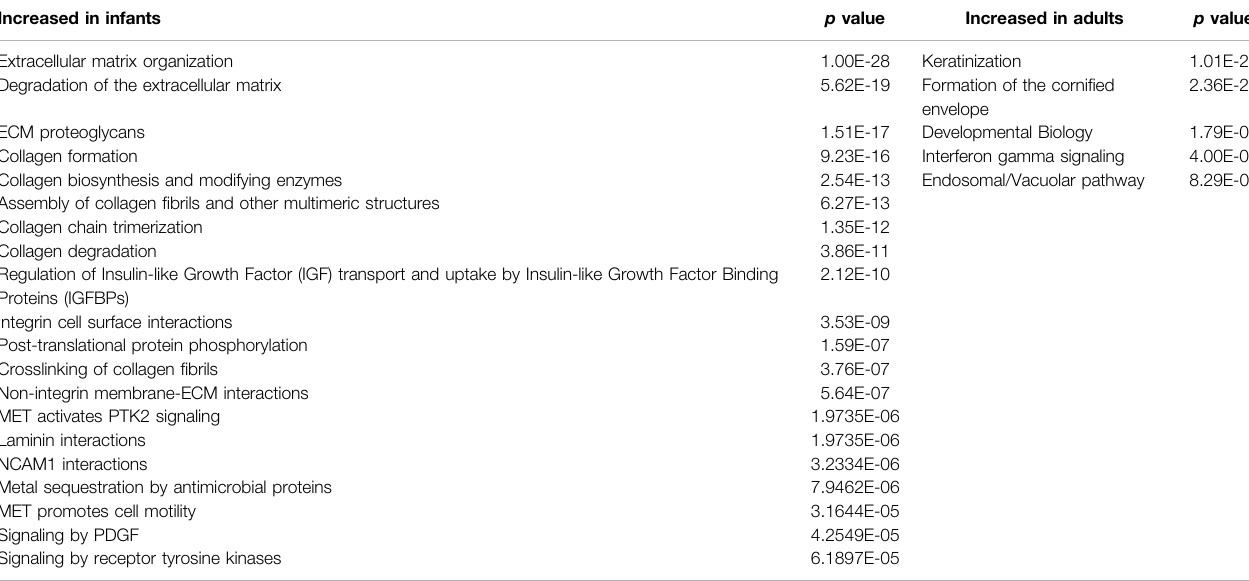
TABLE 2 | REACTOME pathways with the genes differentially expressed in infant tissues with adjusted p values < 0.001 compared with adults and for adult tissues with adjusted p values < 0.001 compared with infants. Increased in